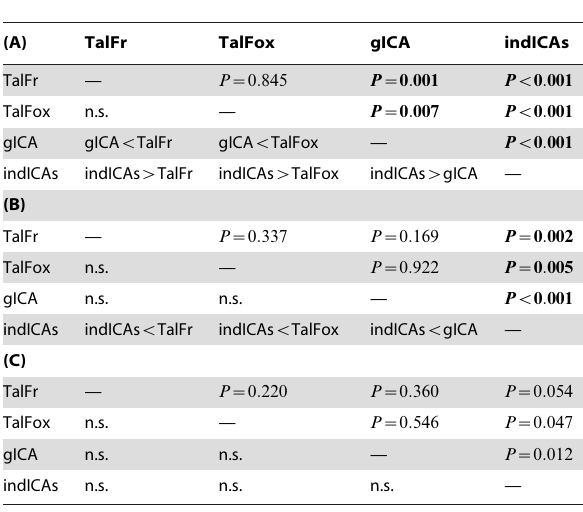
(A) Integration. (B) Absolute integration change. (C) Relative integration change. Upper triangular matrix: significance level of an effect of method. Significant P - values at a threshold of p ~ 0 : 05 corected are emphasized in bold. Lower triangular matrix: direction of effect; n.s.: nonsignificant. Note that, since changes are usually negative, a larger change means a change that is smaller in amplitude.